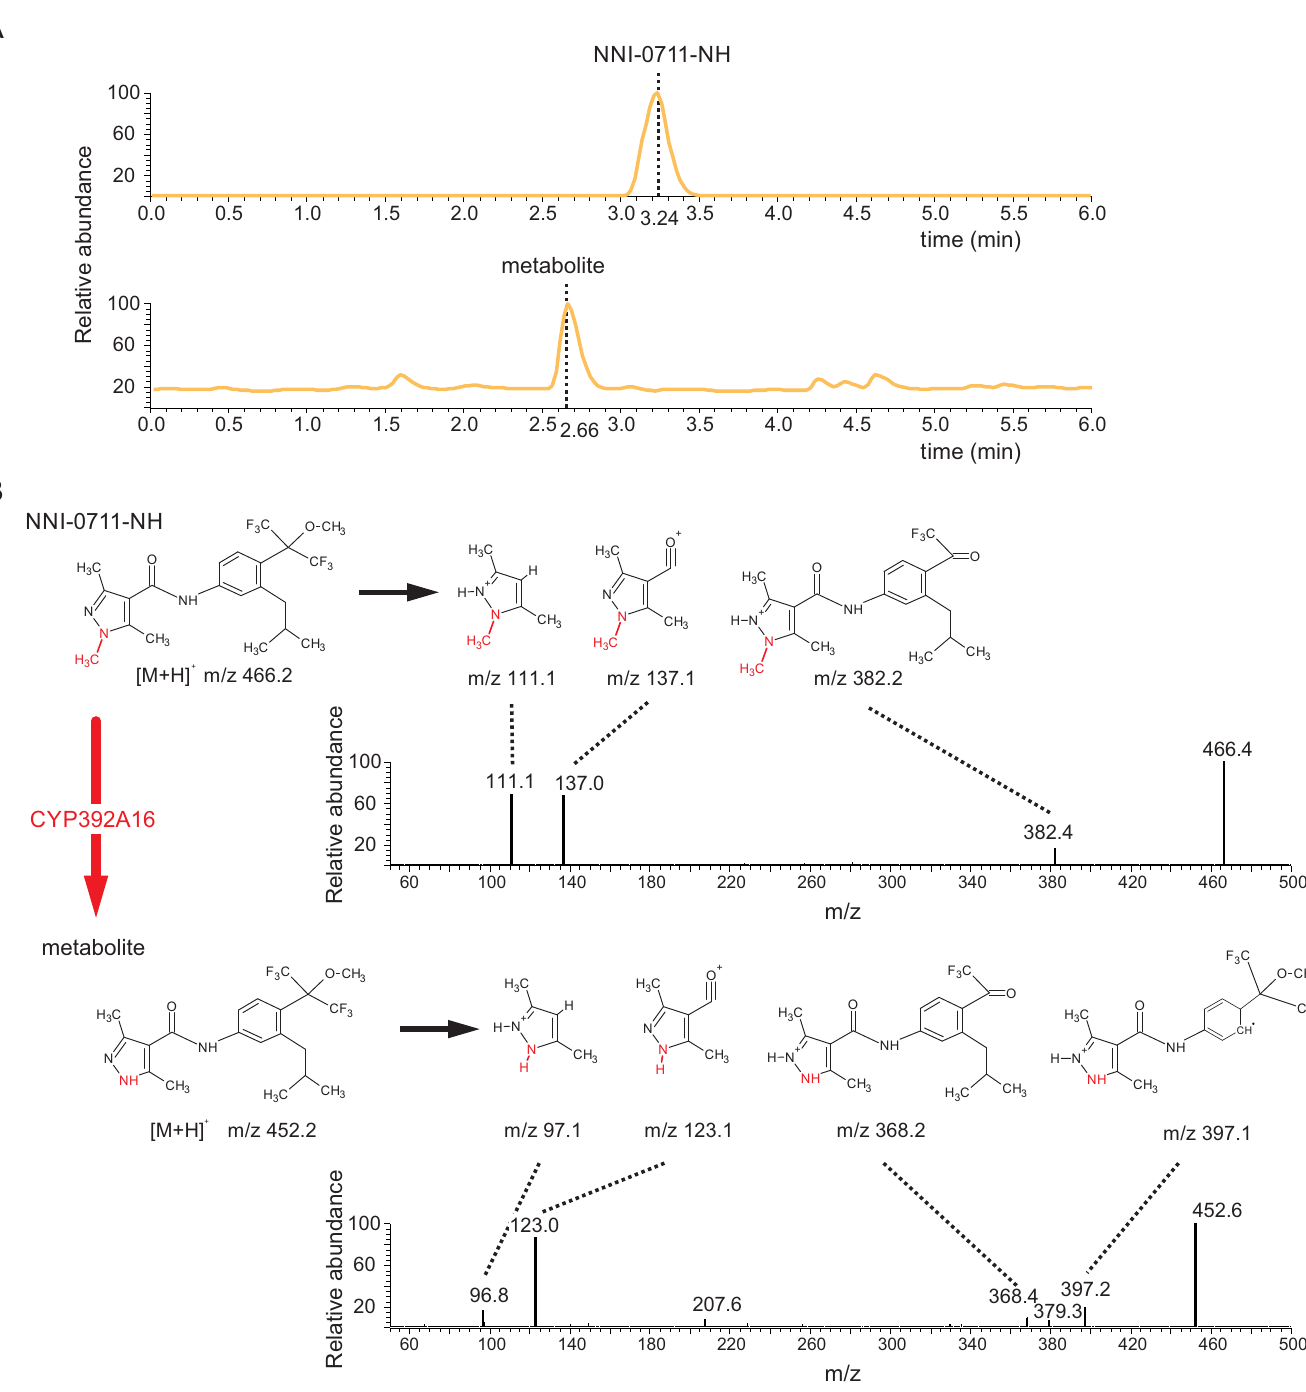
PLOS Genetics | https://doi.org/10.1371/journal.pgen.1009422 June 21,